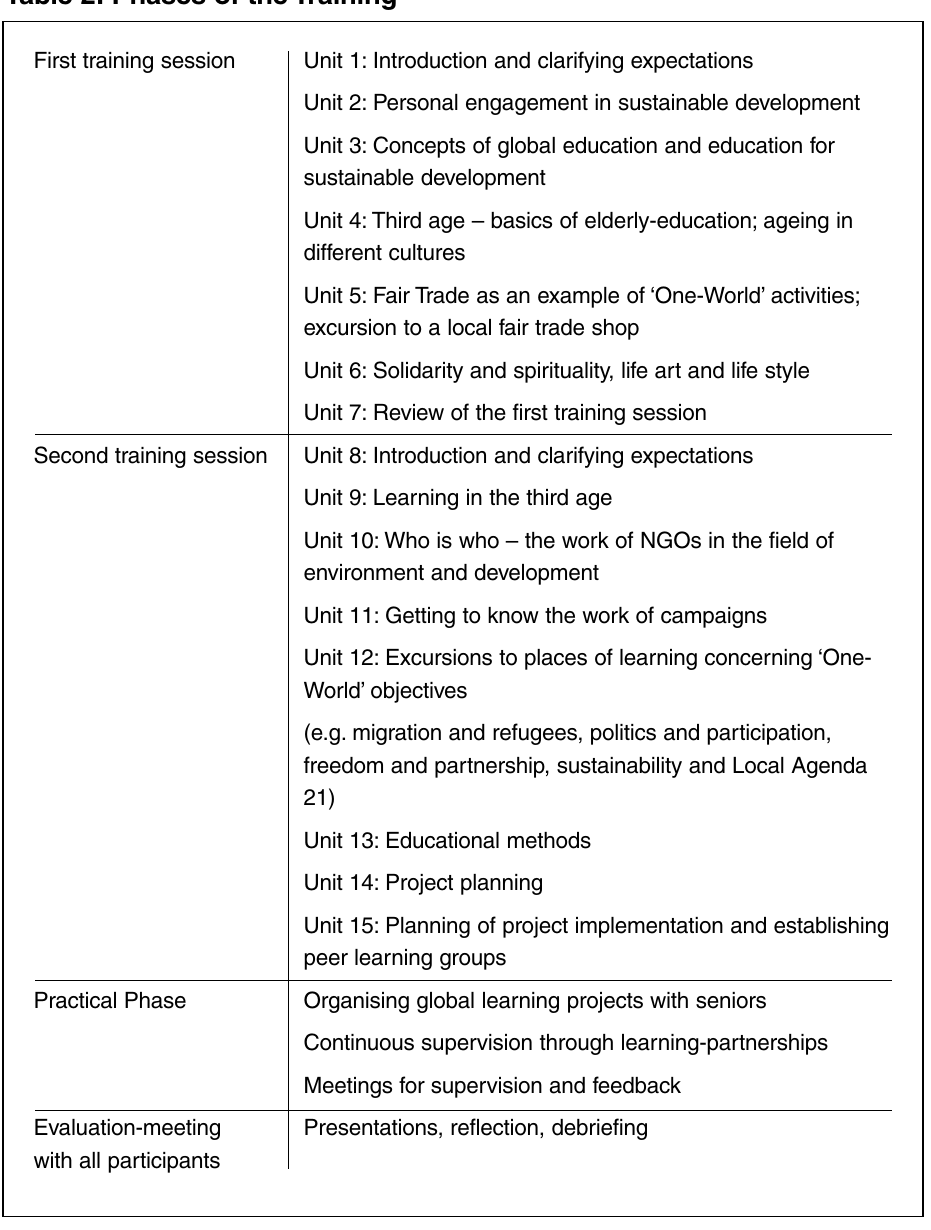
Table 2: Phases of the